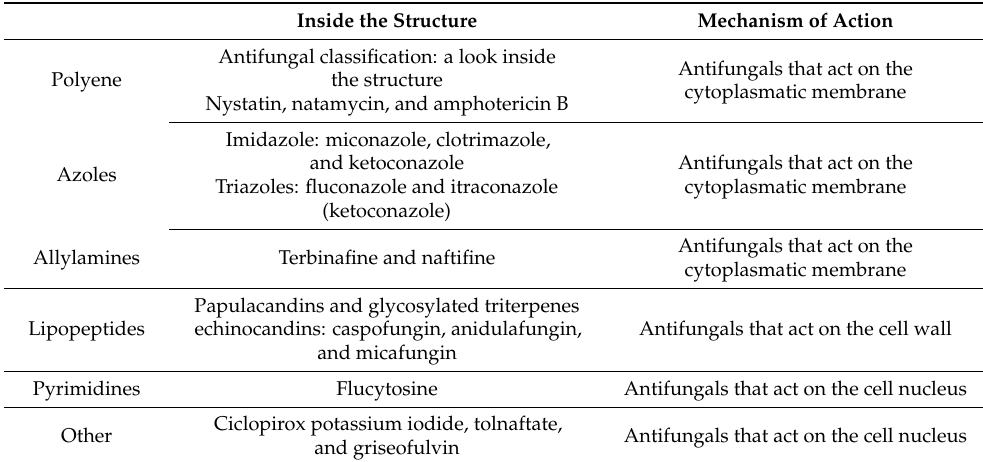
Figure 2. A retrospective look at the evolution of antifungals throughout history. Figure adapted from [7]. Table 1. Antifungal classification according to structure and mechanism of action [7].